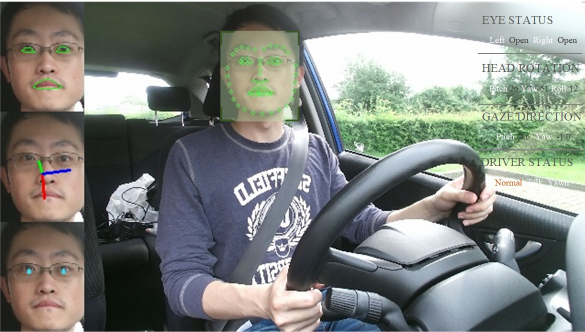
Figure 1. Example of our multi-state driver monitoring